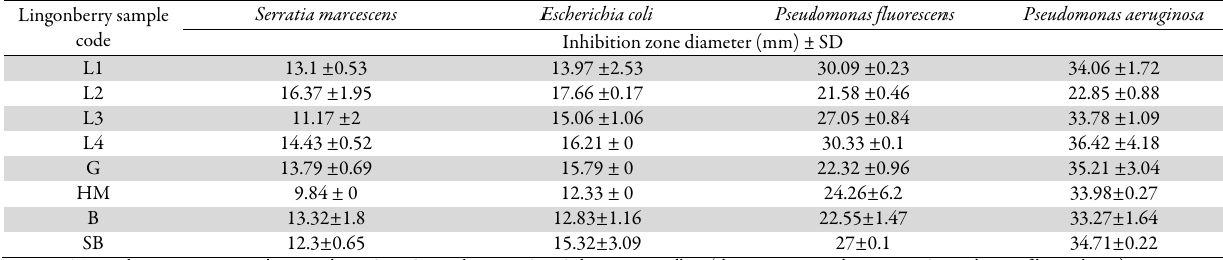
Table 3. Antimicrobial effect of Lingonberry sample